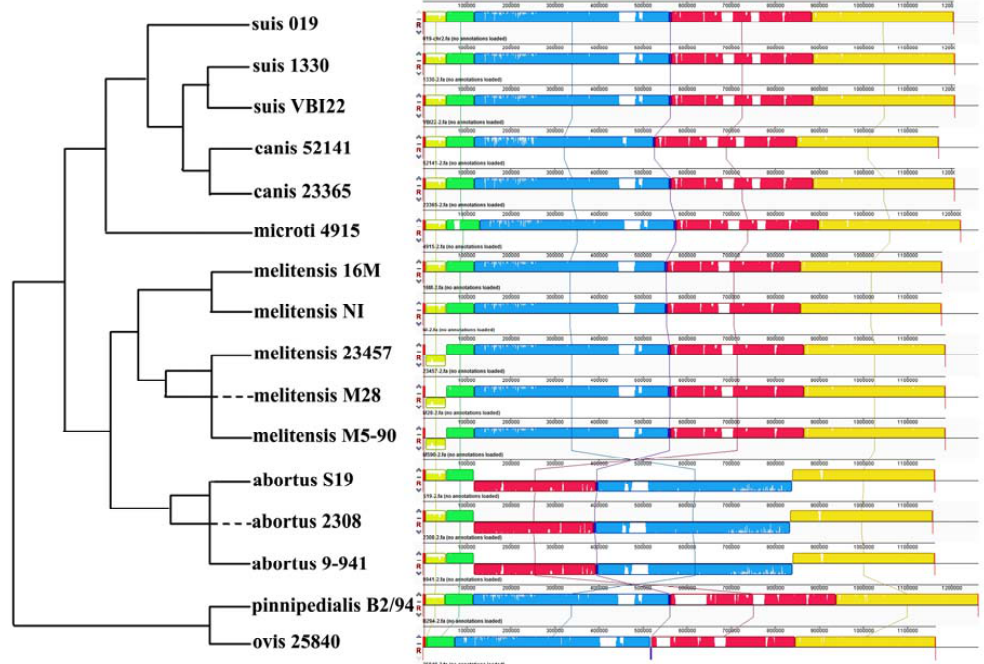
Figure 3. Seven LCBs on Brucella chromosome 2. Seven LCBs on chromosome 2 were built using 16 Brucella complete genomes. The blocks in the same color are connected by lines. A phylogenetic map of the strains derived from Phylogenetic Tree 3 (topology only) is on the left side.